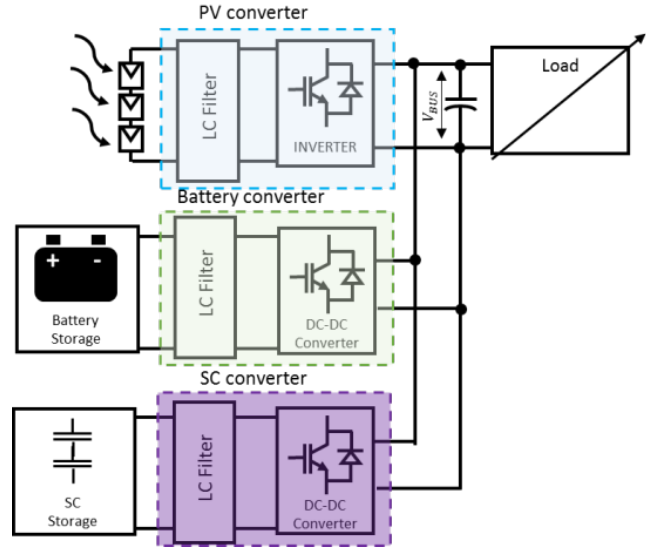
Figure 19. Scheme of the SC nanogrid adapted from [79].